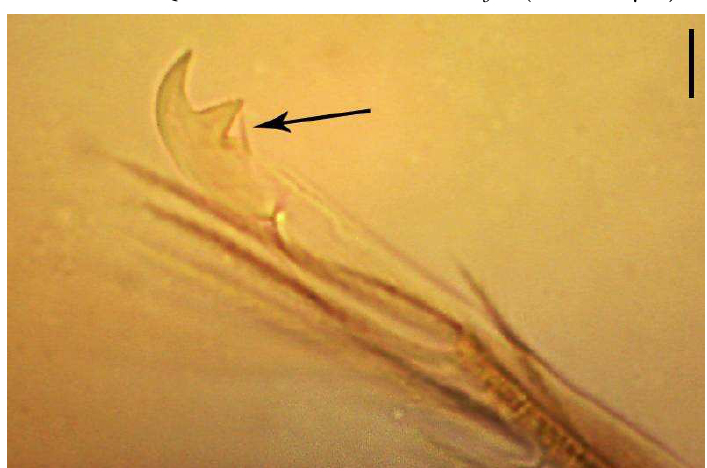
F IGURE 5. Mucro with basal spine in H. major (scale: 25 µm) . Lepidocyrtus